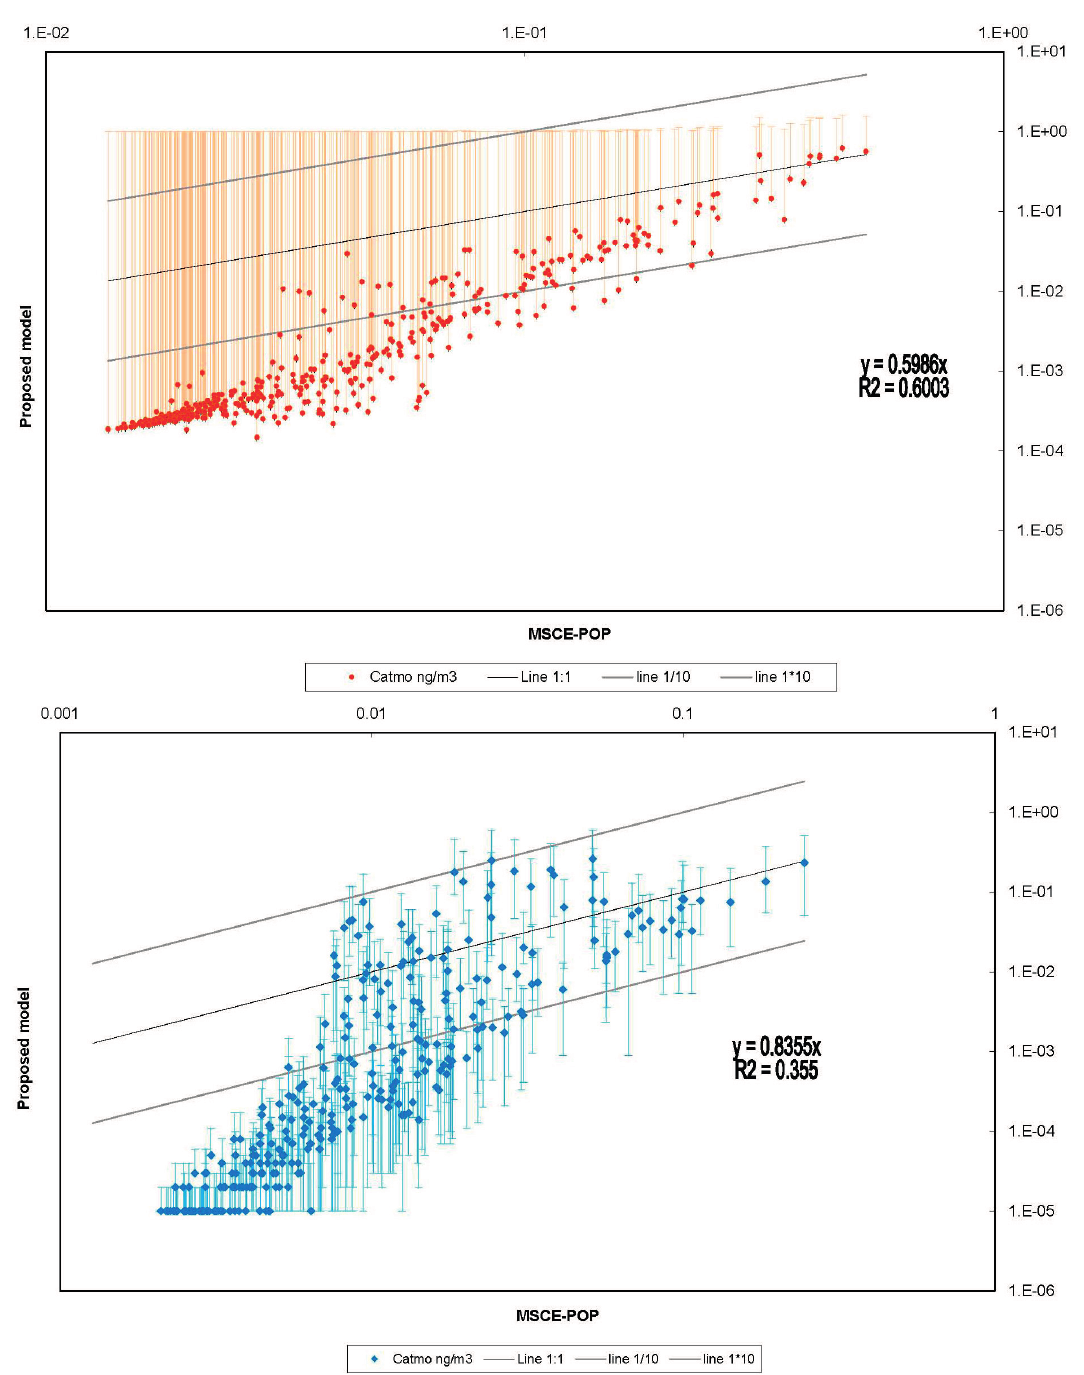
Figure 4. A comparison of the average concentrations in the atmosphere (in ng/m 3 ) in 1995 and 2005 derived from Equation (5) and the MSCE-POP model,